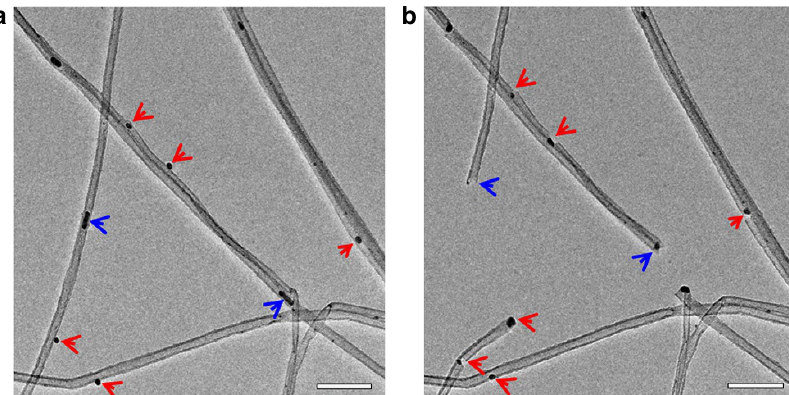
Figure 1 | TEM images of several MW-CNTs before and after oxidation. ( a ) TEM image shows several MW-CNTs before oxidation at 250 (cid:2) C; ( b ) TEM image shows the same region as a but after oxidation at 250 (cid:2) C for 25min with 2mbar O 2 , clearly demonstrating the Ag catalysed oxidation of the MW-CNTs. Scale bar, 50nm.